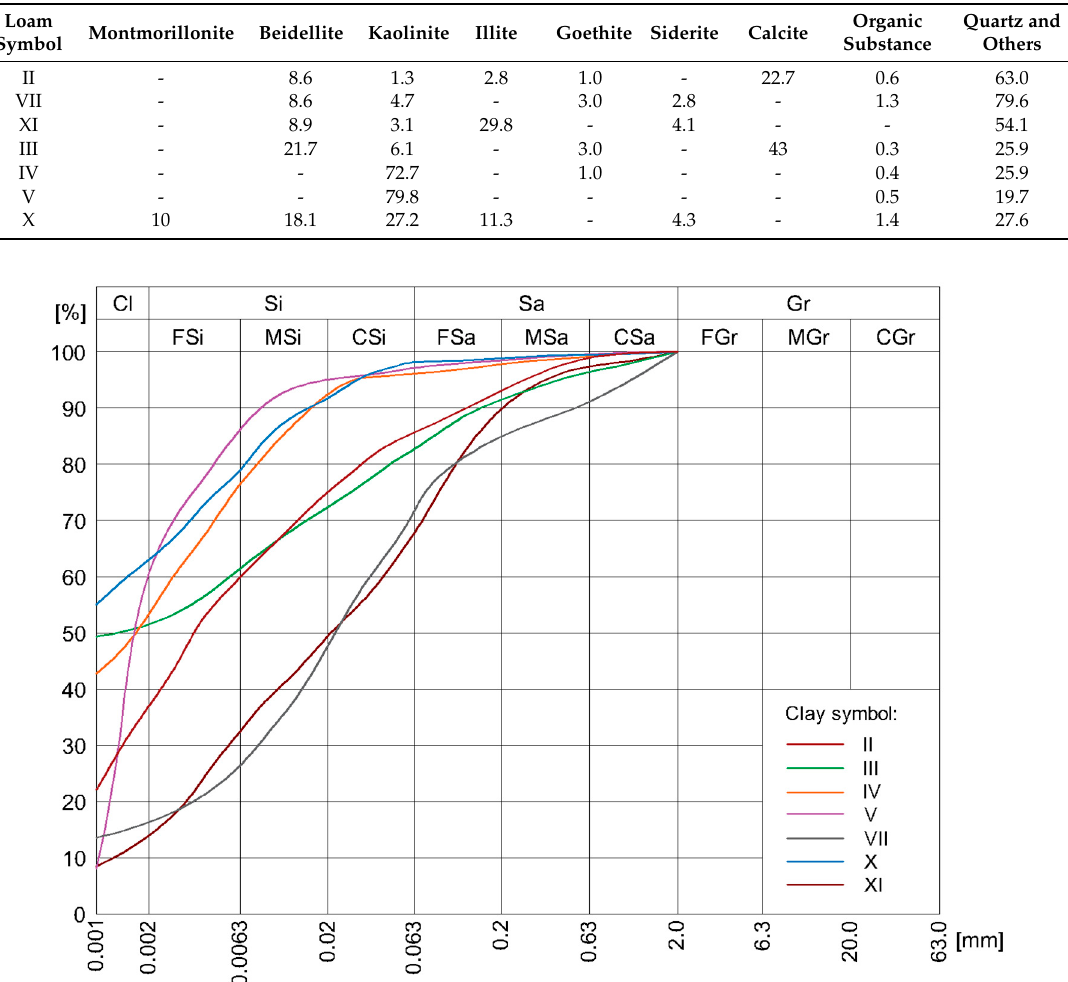
Table 1. Mineral composition of each loam (%).